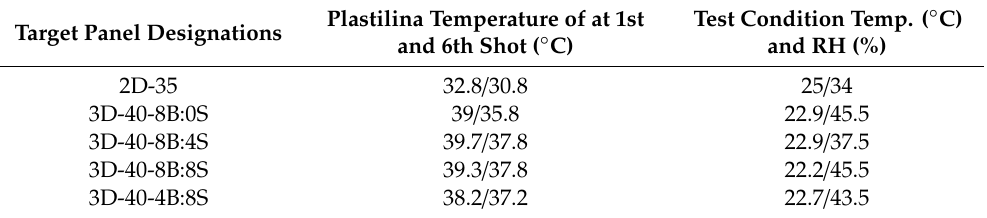
Table 3. Ballistic-testing parameters and conditions during the